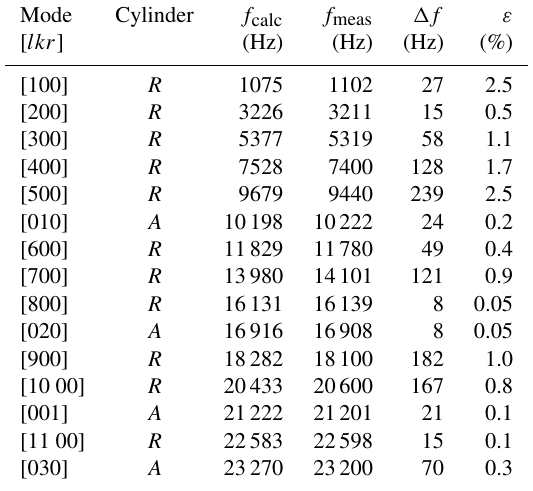
Table 3. Overview of the resonance modes of cell number 4 with the designation of the resonance mode and cylinder, the calcu- lated resonance frequency f calc , the measured resonance frequency f meas , the difference between the calculated and measured reso- nance frequency (cid:49)f , and the percentage deviation of the calculated from the measured resonance frequency ε = (cid:49)f/f meas , for the